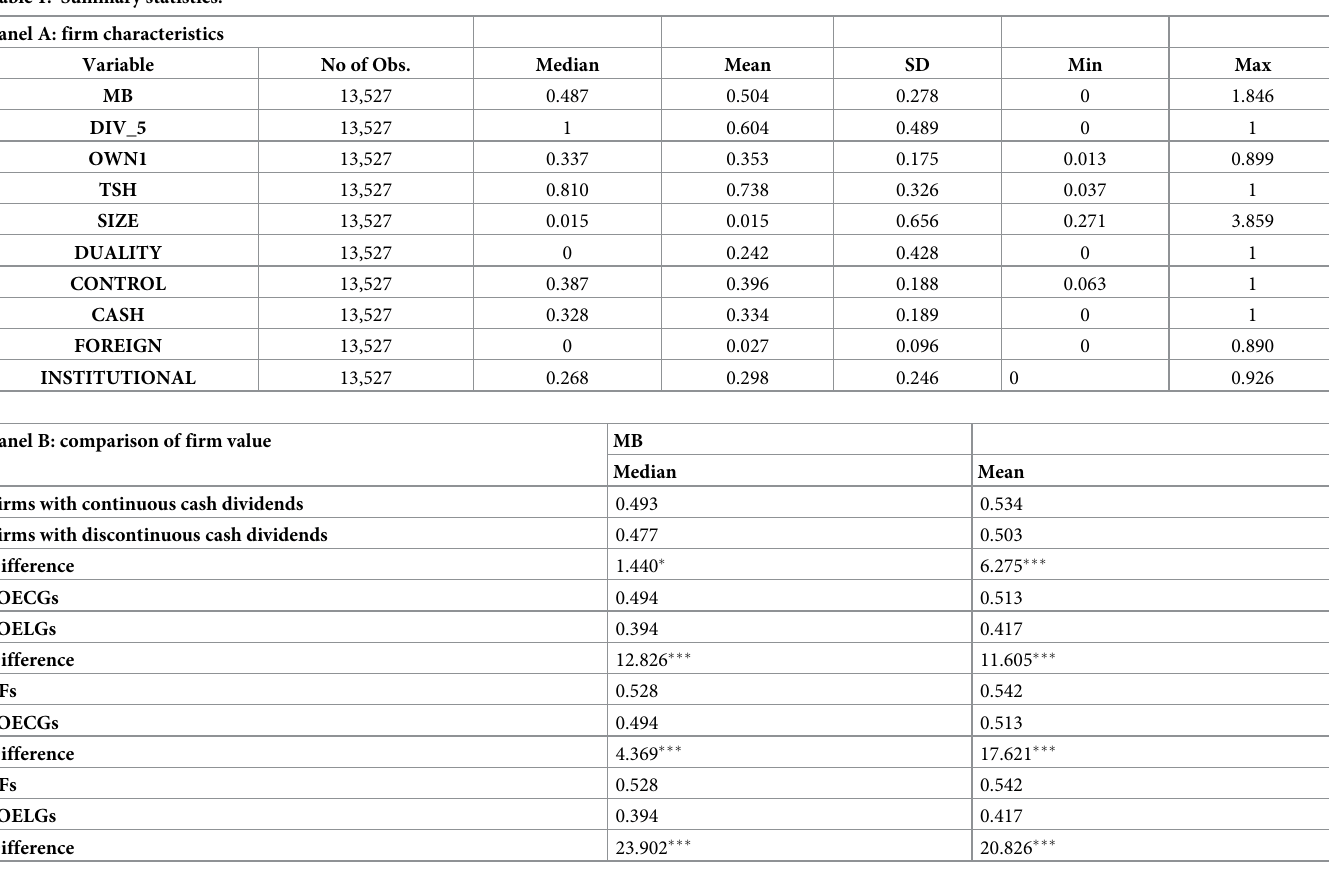
Table 1. Summary statistics. Panel A: firm